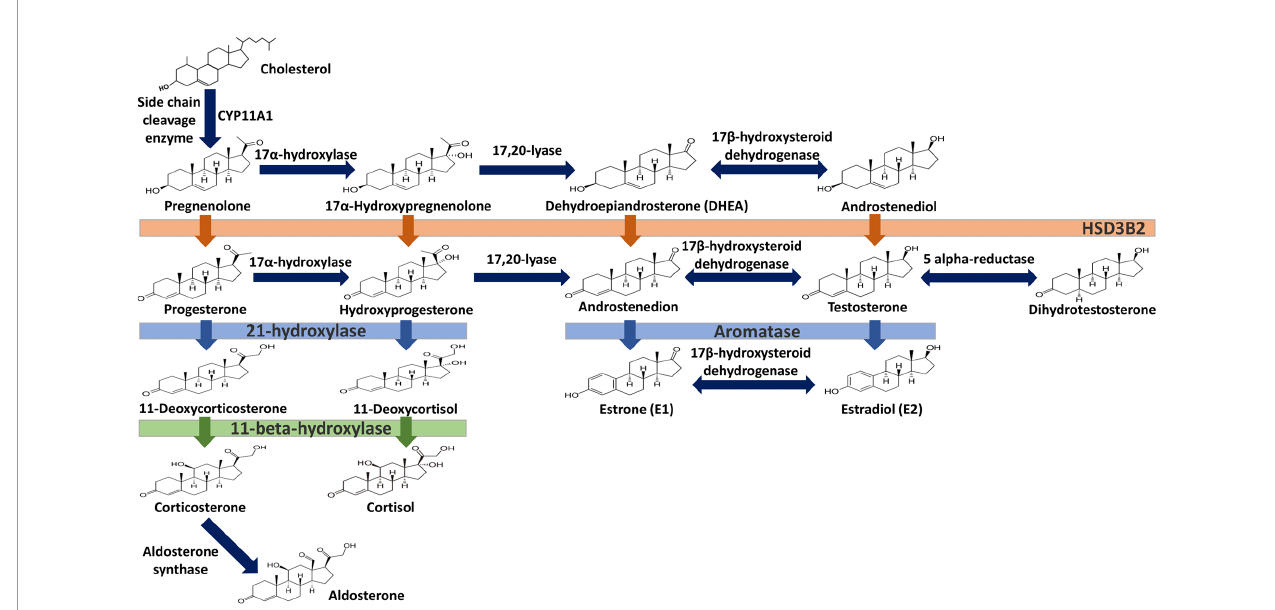
FIGURE 1 | Steroid hormone synthesis and metabolism. The diagram designates key enzymatic steps in